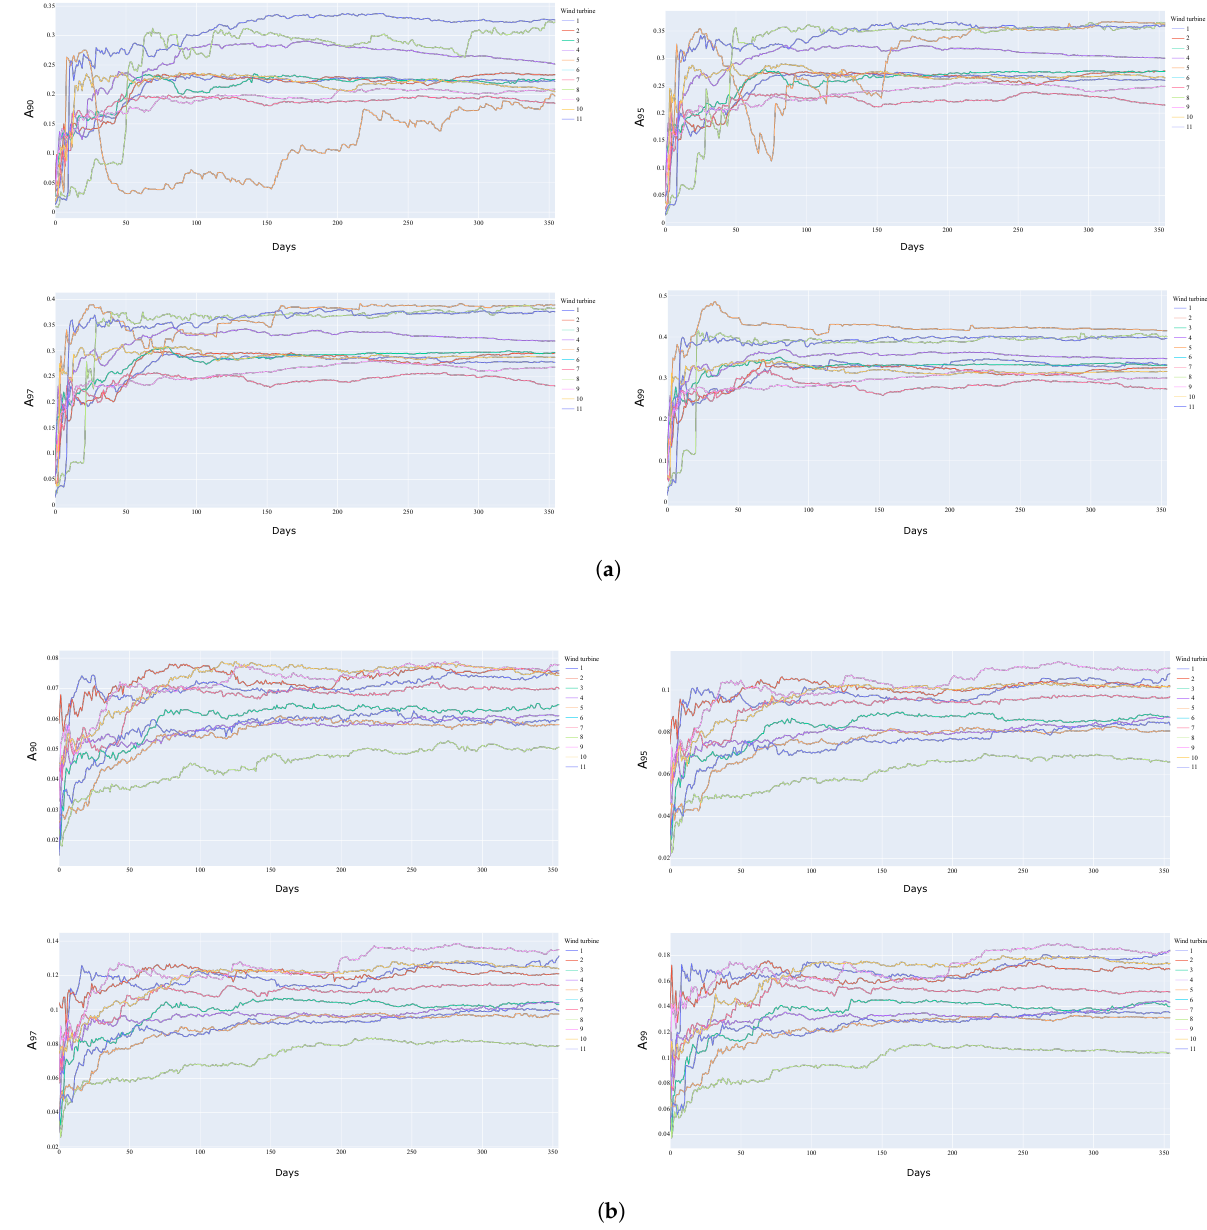
Figure 7. Temperature alarm thresholds calculated through time. ( a ) generator bearing temperature alarm; ( b ) generator phase winding temperature alarm. For each NBM alarm threshold, we see variability between turbines both in time taken to converge and in absolute value after convergence. In terms of absolute values, Figure 8 shows the variation between turbines after convergence. For each turbine, the average of the final three values of each temperature threshold was used to create box plots for direct